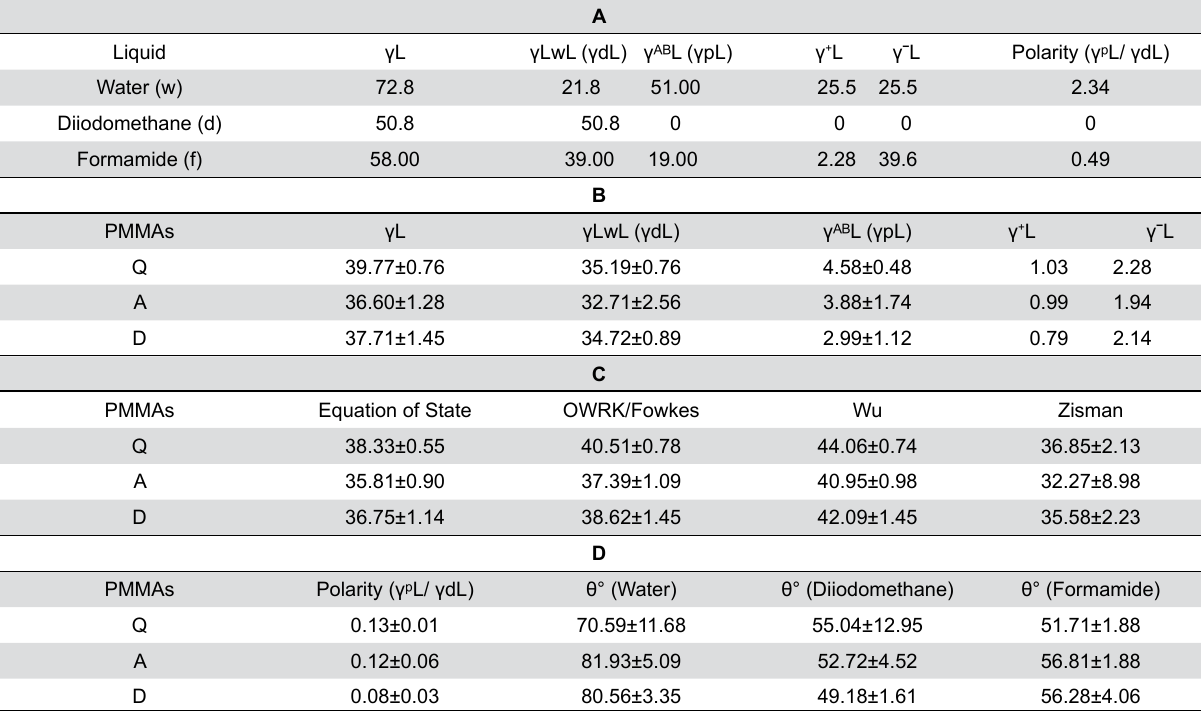
Table 3- A) Acidic, Basic Components of Surface Free Energies of Test Liquids used in this work (mJ/m 2 ). B) Surface Free Energy Components of PMMAs Surface Calculated by Acid-Base Approach (mJ/m 2 ). C) Surface Free Energy of PMMAs Surface Calculated by the Other Methods (mJ/m 2 ). D) Polarity and Average Contact